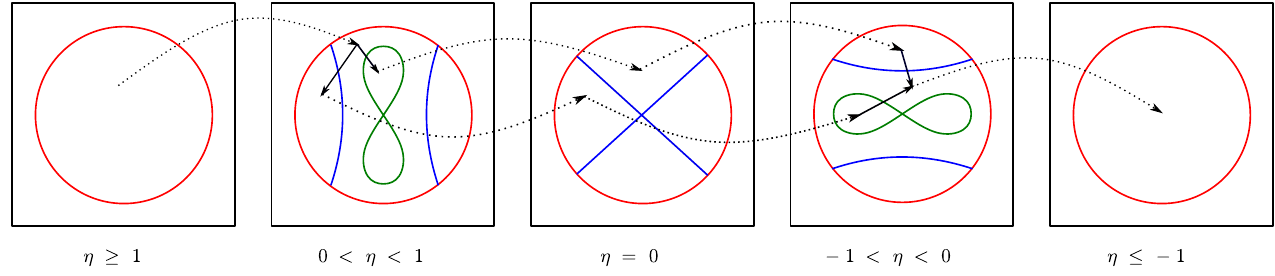
FIG. 5. Sketch of the resonance-crossing process ( η decreases from left to right) for the simple case α ¼ 0 . The dotted arrows indicate the transition between regions that do not imply separatrix crossing, whereas continuous arrows indicate the transition between regions that require separatrix